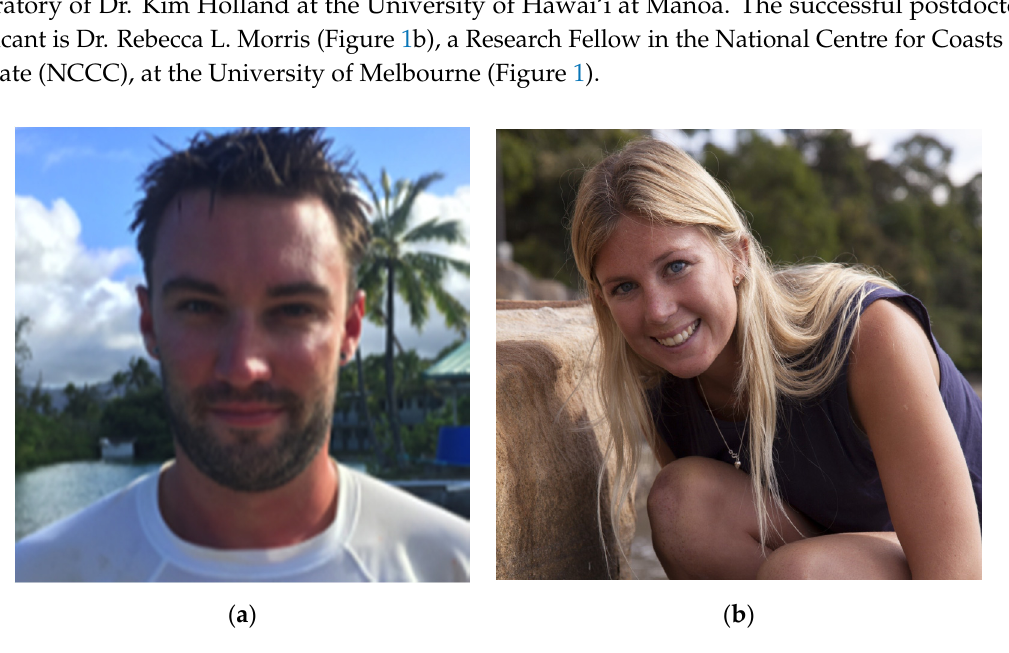
Figure 1. ( a ) Mr. Daniel M. Coffey; ( b ) Dr. Rebecca L. Morris.